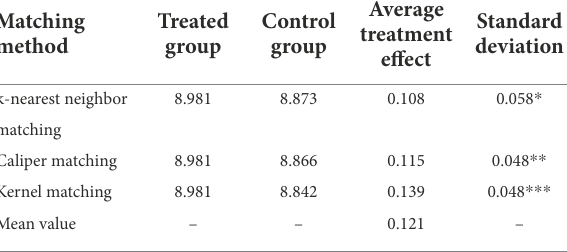
TABLE 5 Estimated impact of clan networks on farmers’ entrepreneurial